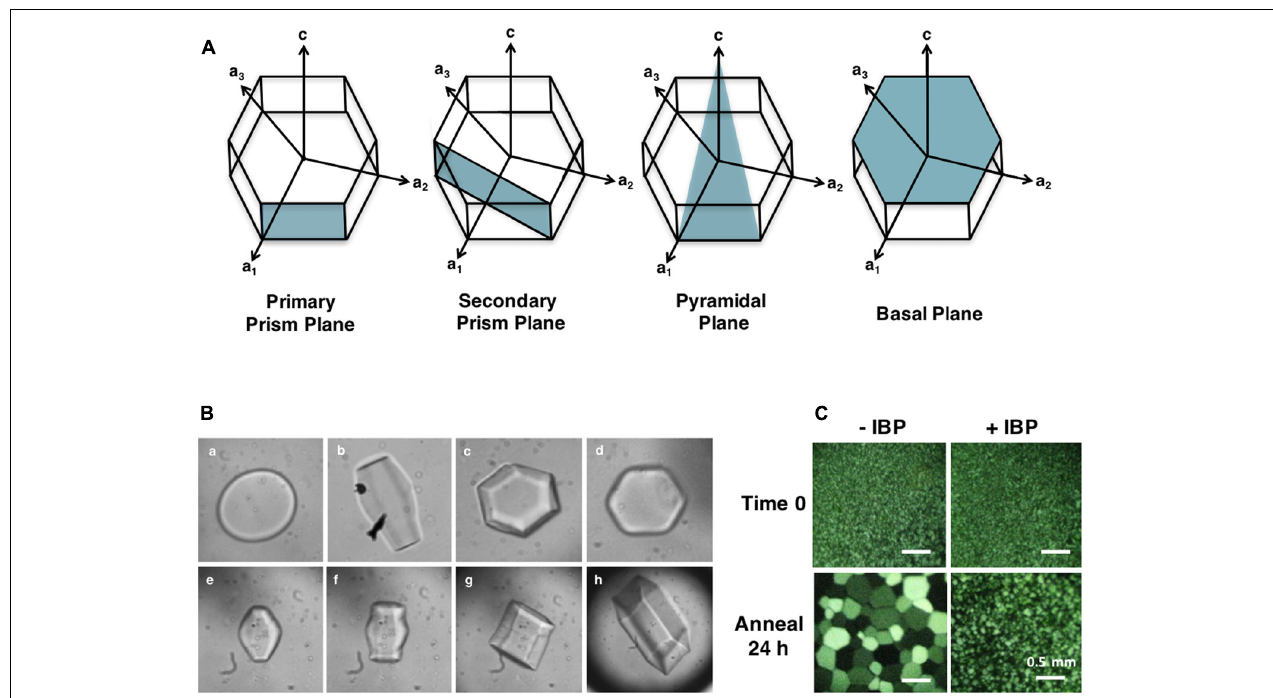
FIGURE 2 | (A) Ice crystal planes adsorbed by IBPs. Plant IBPs have demonstrated affinity for primary and secondary prism planes, as well as basal planes. No plant IBPs have yet been identified with pyramidal plane affinity. Lp AFP, for example, binds both primary prism and basal planes. (B) Ice crystal morphologies in the absence (a) and presence of an IBP from two grasses ( b–h ). Lolium perenne Lp AFP (1 mg/mL) ice crystal shaping with the a-axes facing toward the reader is shown in B , and with the c-axis toward the reader in c . Shaping in the presence of low concentrations of IBP from Brachypodium distachyon (0.01 mg/mL) is shown in d . Panels ( e–h ) show an ice crystal burst as the equilibrium freezing point is exceeded. (C) Ice crystal growth following a 24 h annealing period at − 6 ◦ C demonstrating ice recrystallization inhibition (IRI) by IBPs. Buffer without IBPs (–IBP) contains 100 mM Tris-HCl and 50 mM NaCl. Samples with L. perenne IBP ( Lp AFP) (+IBP) were diluted to 0.5 mg/mL in the same